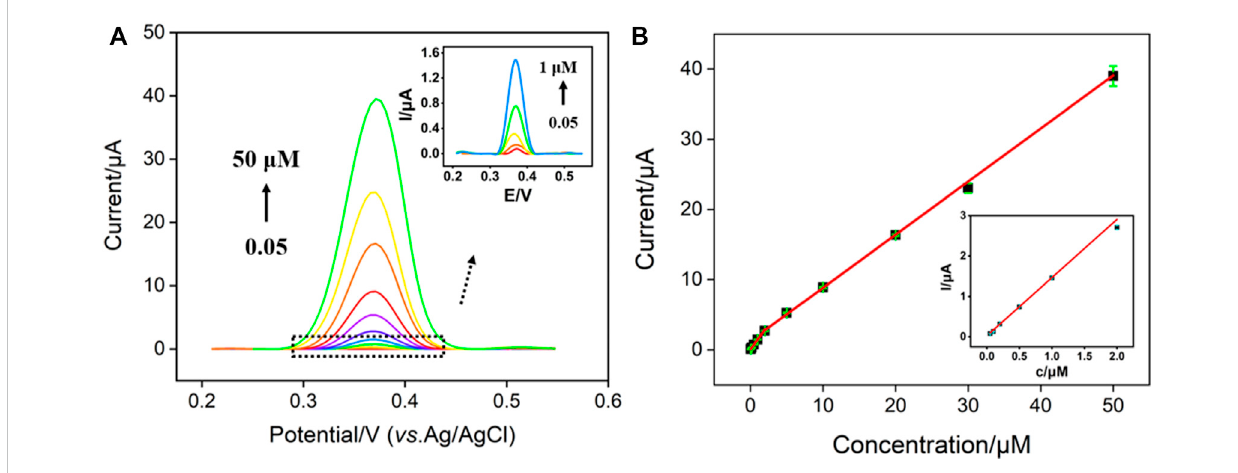
fi ed view of the DPV curves